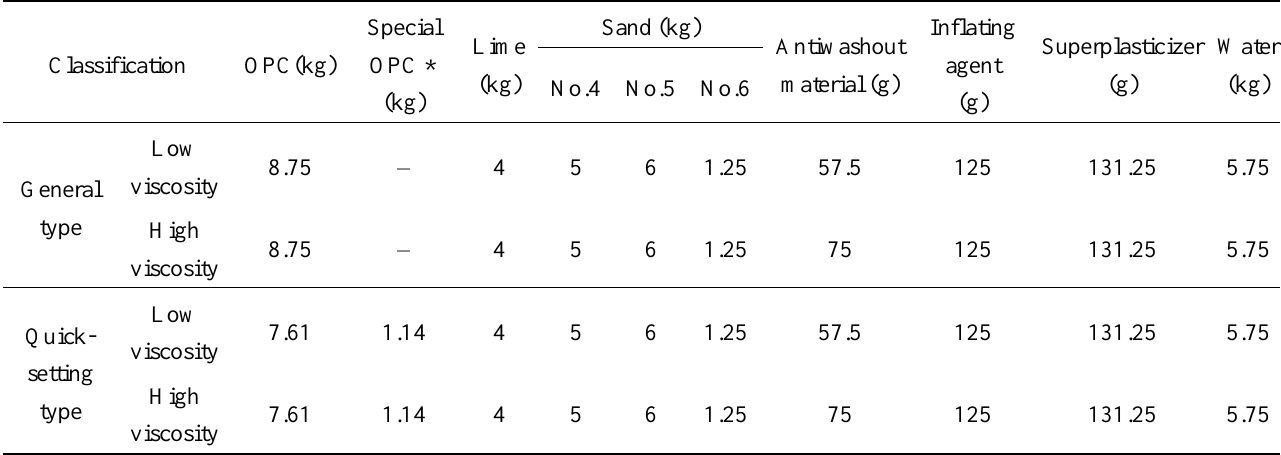
Table 1. Mixing ratio of the injected materials (25